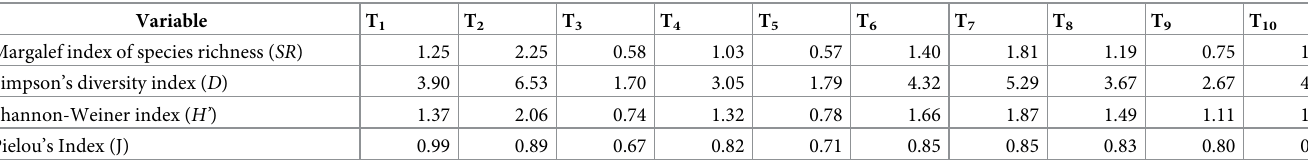
Table 2. Diversity indices recorded in